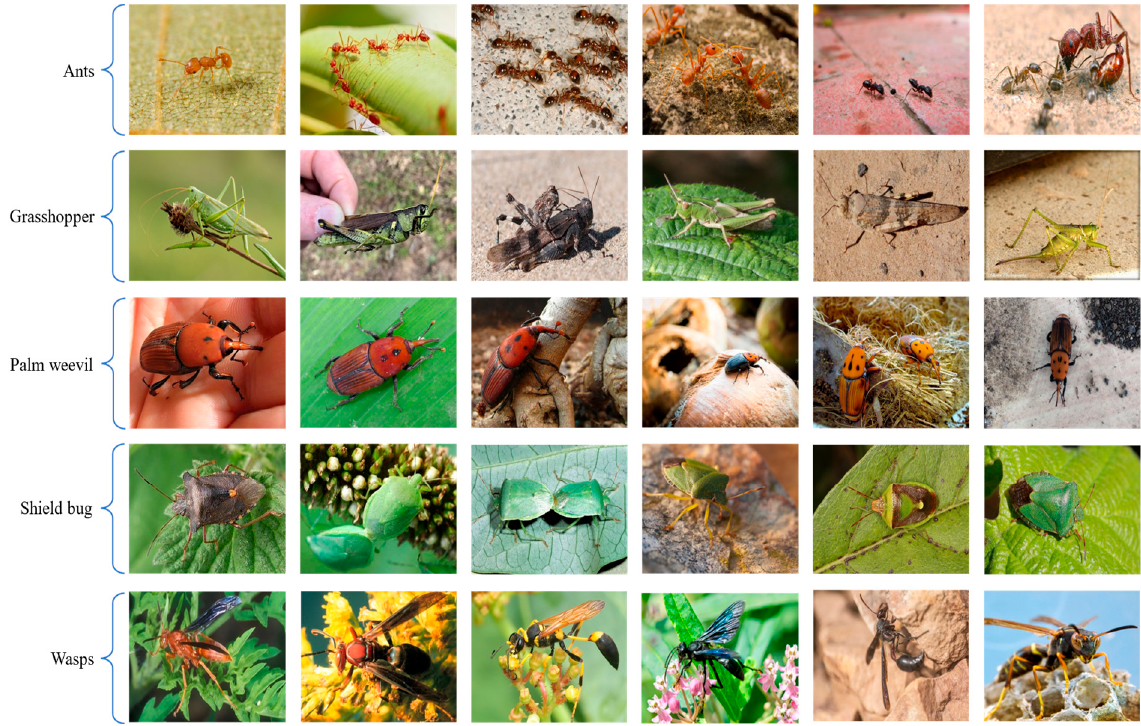
Figure 5. Sample images of each class of the self ‐ created dataset for early pest detection.